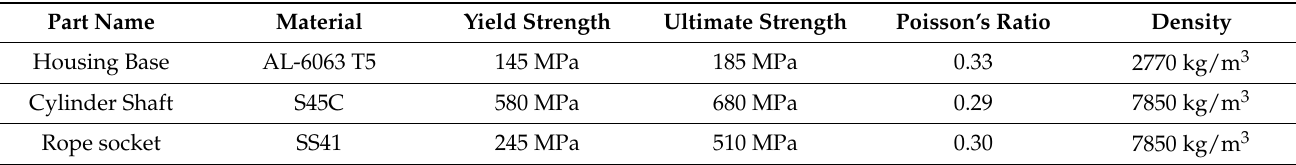
Table 2. Mechanical properties of the materials